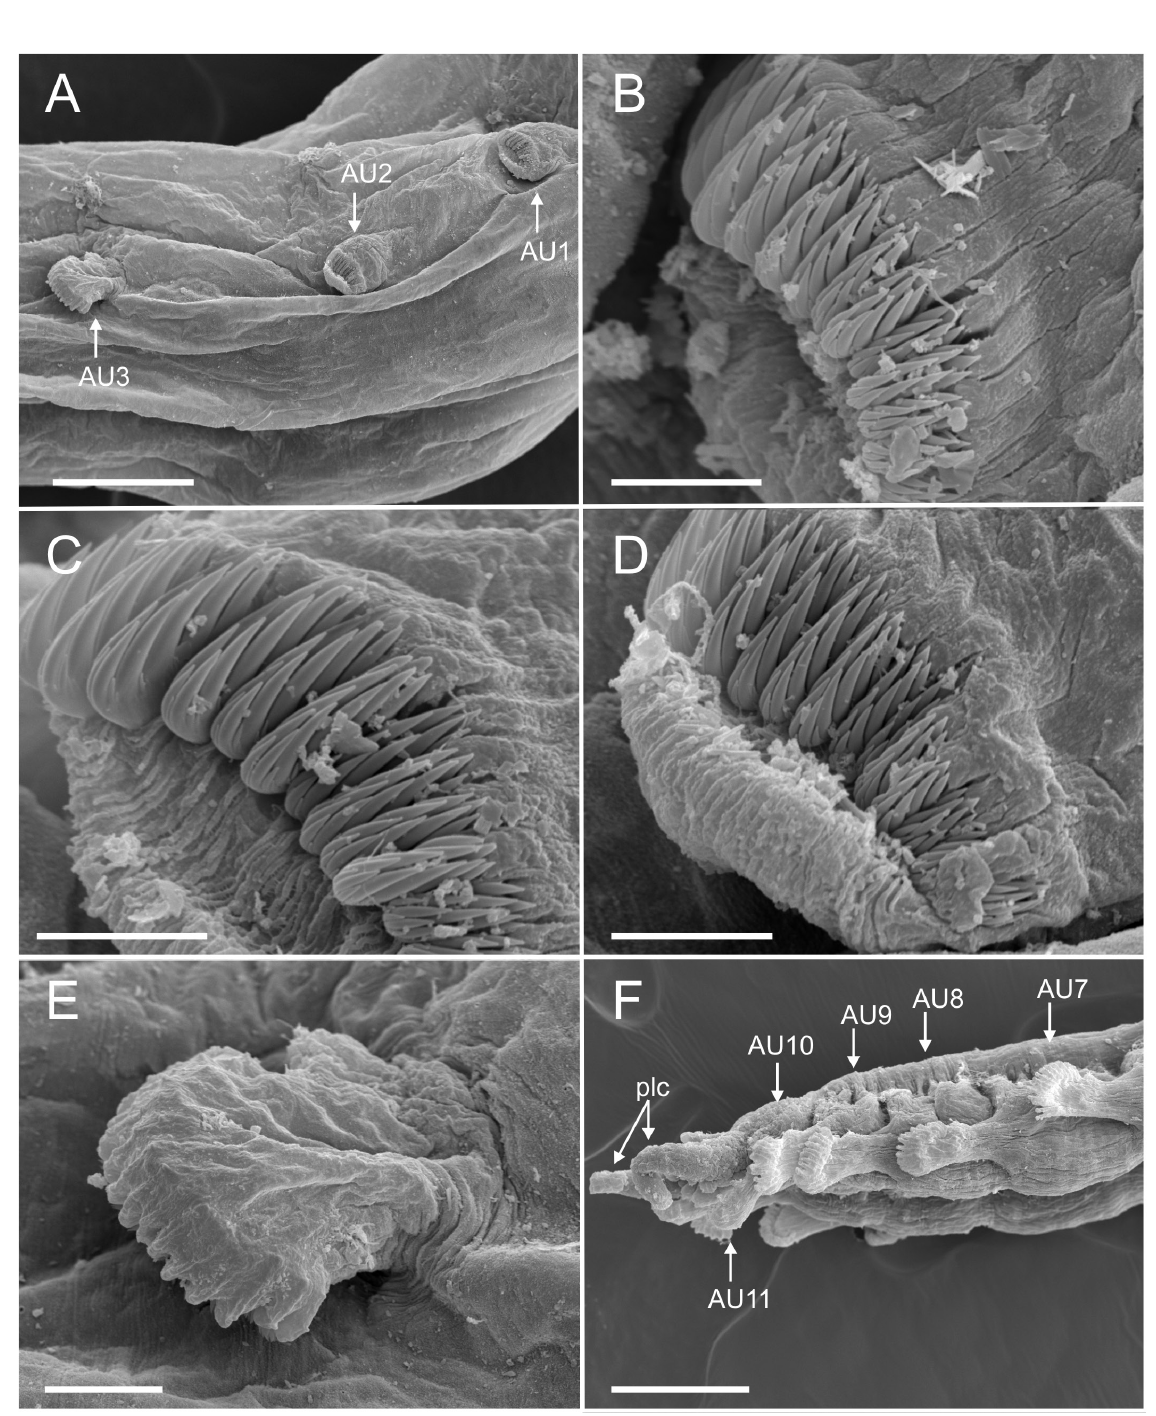
Fig. 3. Ampharete oculicirrata sp. nov., paratype MNCN 16.01/18482_spec. 1. A . First three abdominal uncinigers, lateral view. B . Thoracic unciniger 11. C . Abdominal unciniger 1. D . Abdominal unciniger 2. E . Abdominal unciniger 3. F . Posterior end, from AU7 to pygidium. Abbreviations: AU = abdominal unciniger; plc = pygidial lateral cirrus. Scale bars: A, F = 100 µm; B–D = 10 µm; E = 15